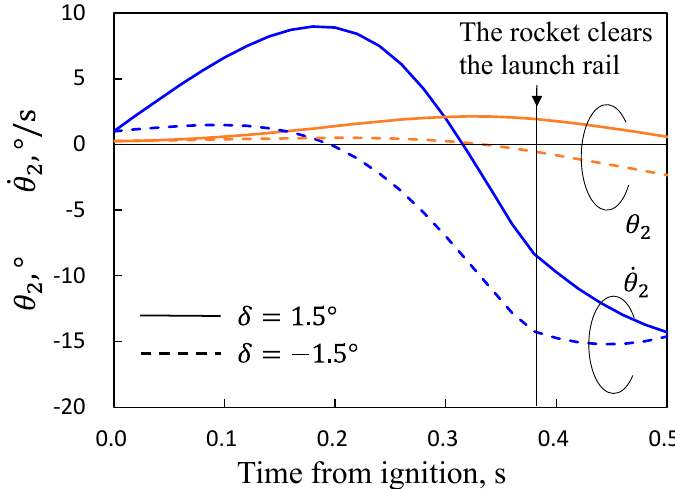
Figure 10. Elevation variations due to thrust misalignment.